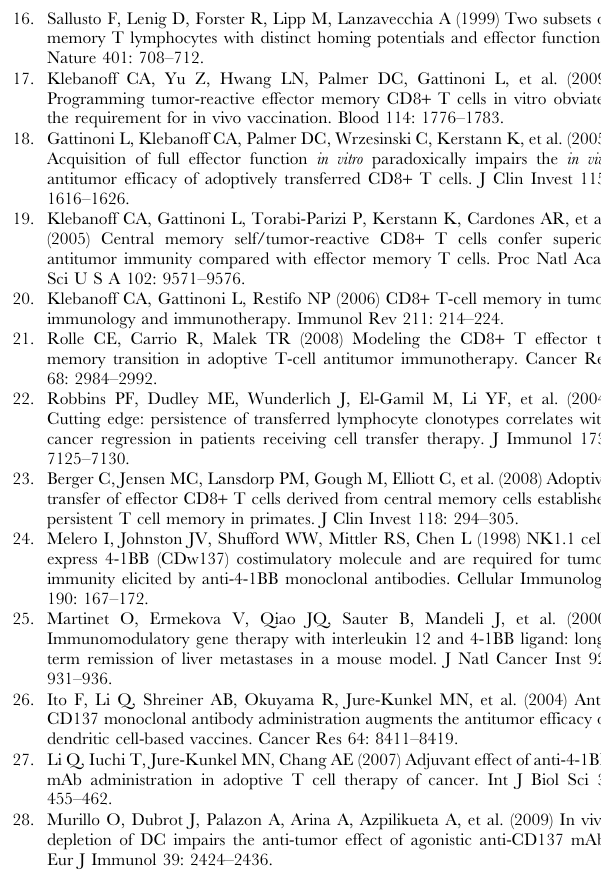
the naı¨ve and rechallenged mice are shown on the left and right panel, respectively. (n) indicates the number of mice in each group.